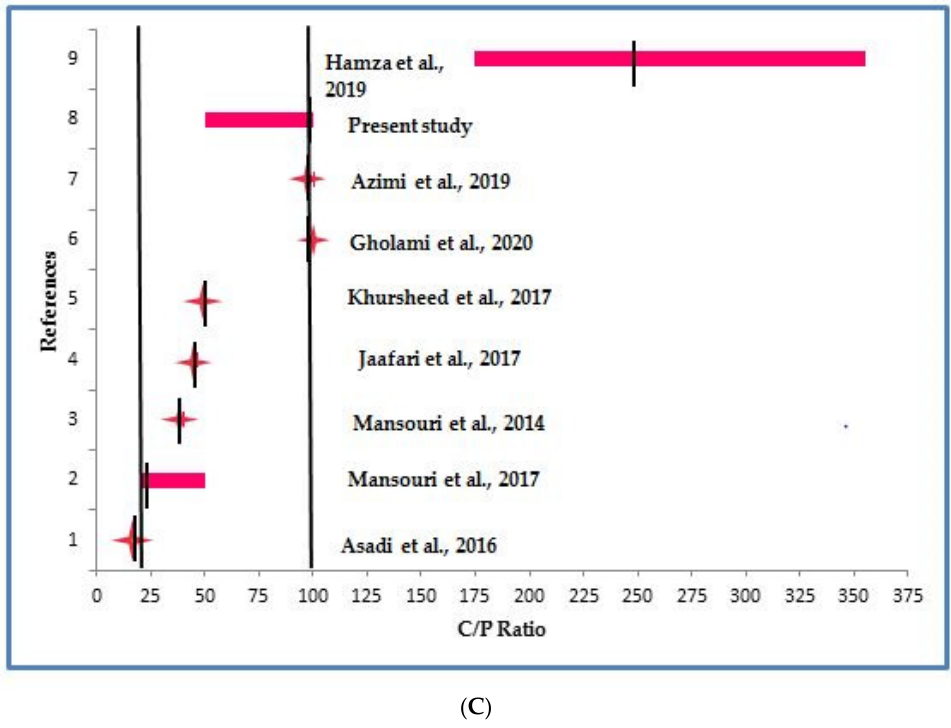
Figure 5. Review graphs for operating range along with optimum values for: ( A ) cycle time; ( B ) C/N ratio; and ( C ) C/P ratio. References included are ( A ) [15,19,23–25,28,35,37,44,53–56]; ( B ) [6,22,26,28–30,34,36,37,44,45,53]; ( C ) [19,22–24,30,35,37,54].